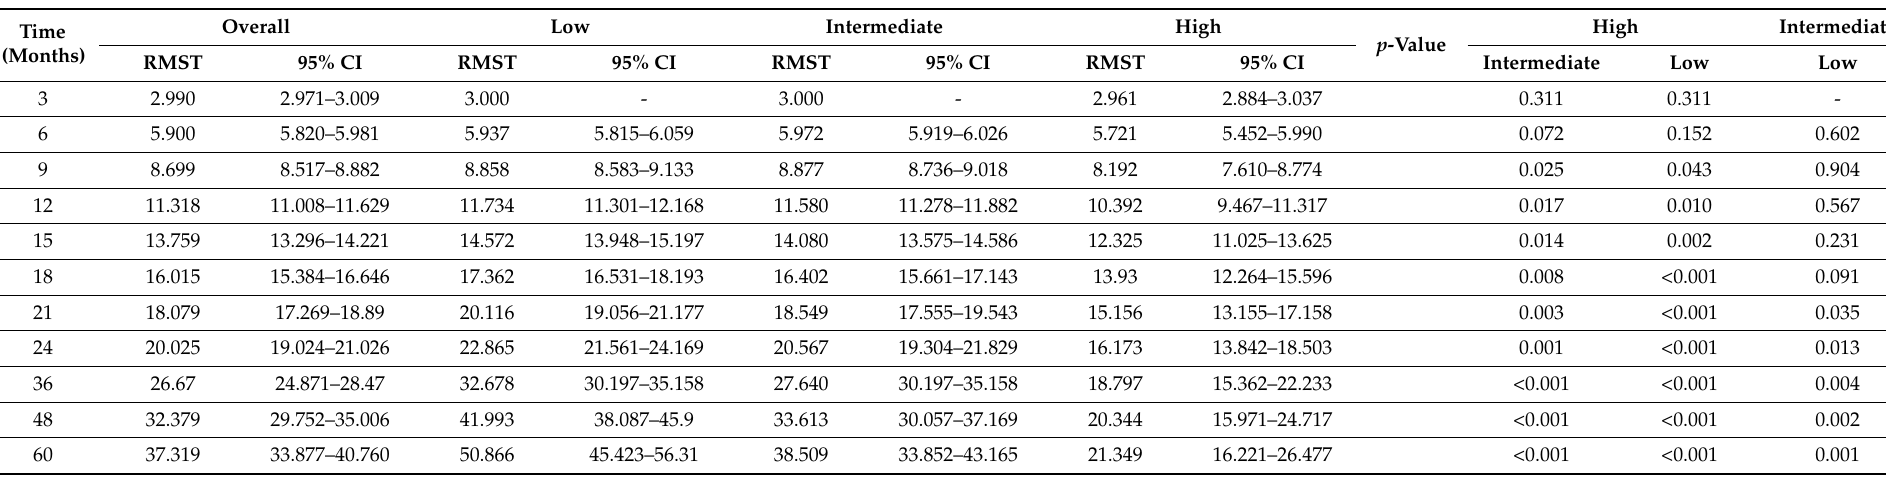
Table 3. Restricted mean survival time of the low-, intermediate-, and high-risk groups for recurrence-free survival, and their comparisons.